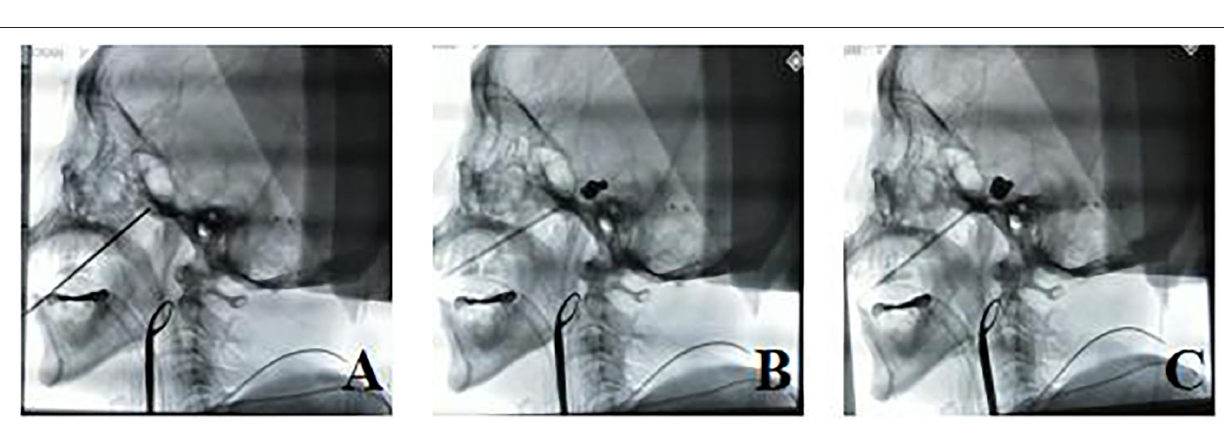
not ideal, the cannula direction needed to be adjusted in time to re-puncture. The filling fluid of the balloon was 0.45–0.75 ml. It took 120–180 s to compress the semilunar segment, the contrast agent in the balloon was discharged, the catheter was pulled out, and the compression at the puncture point was about 5